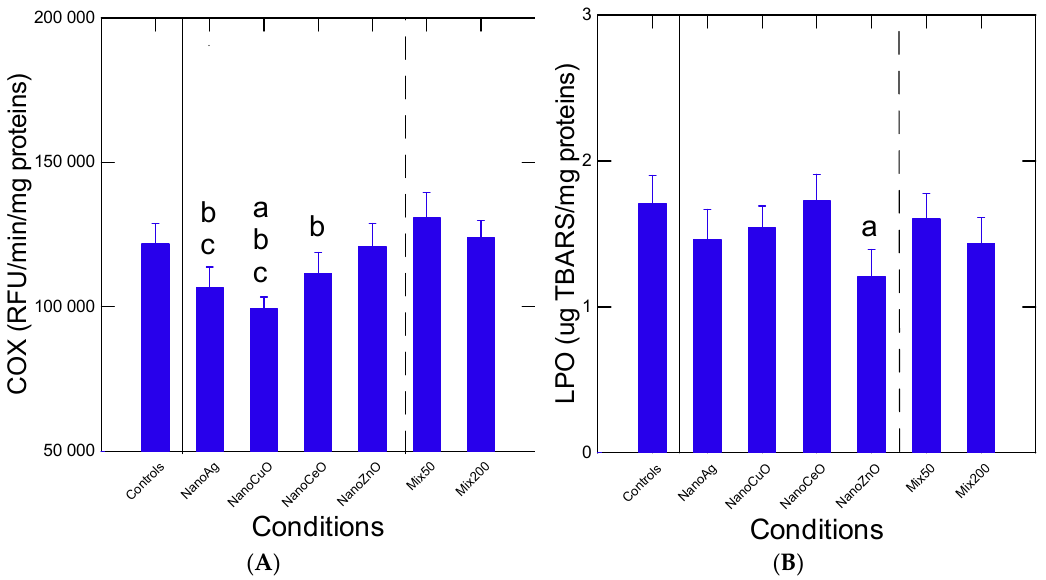
Figure 2. Oxidative stress of nanoparticle mixtures in zebra mussels. Oxidative stress was measured by COX activity ( A ) and LPO ( B ). The data represent the mean with the standard deviation. The letters a denotes a significant di ff erence to controls, the letter b significant e ff ect from the Mix50, and c a significant di ff erence from Mix200.